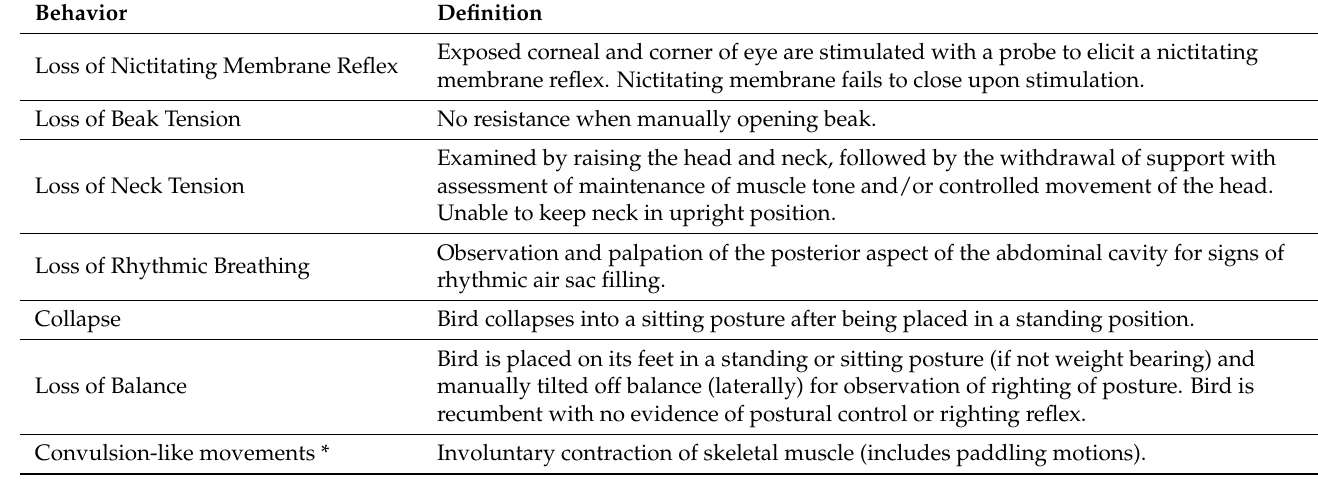
Table 1. Ethogram defining each behavior recorded after the neck cut, assessments were repeated in the same sequence until all reflexes were